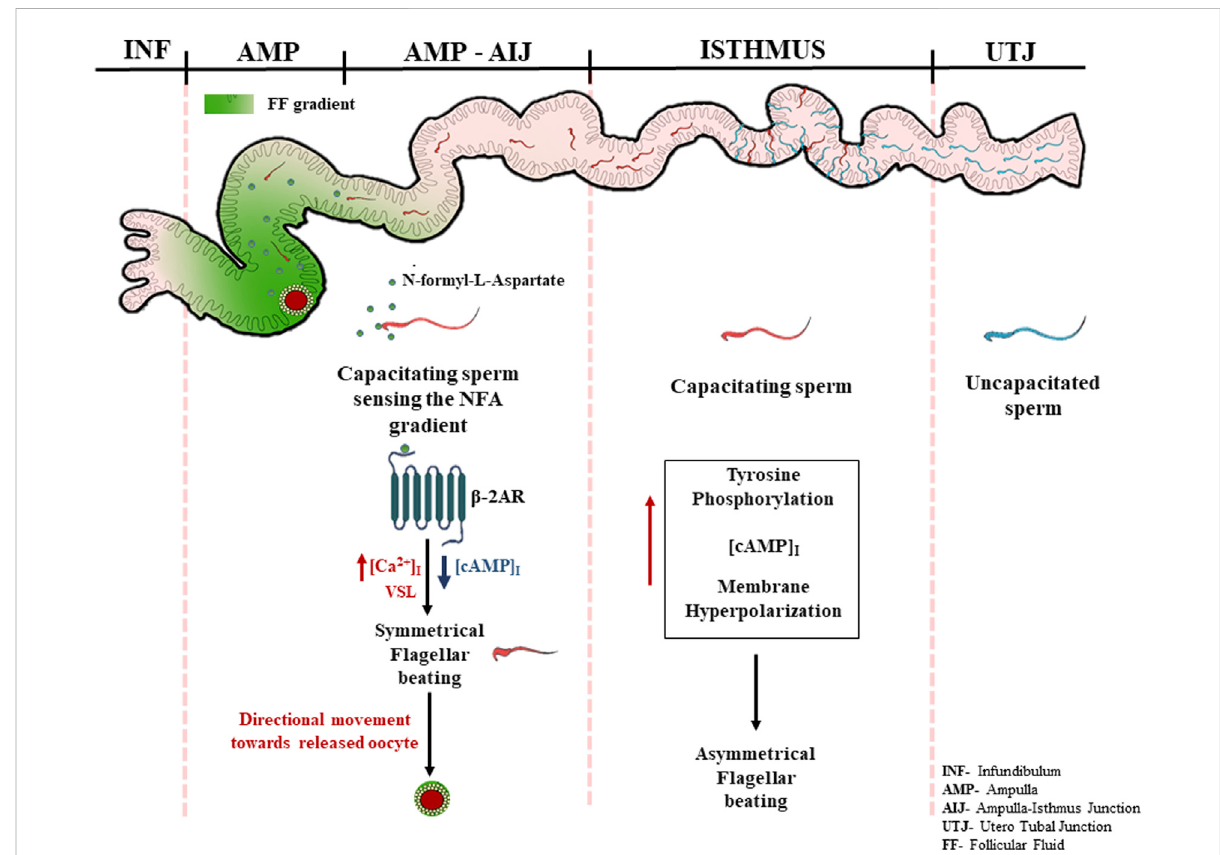
FIGURE 7 Schematic representation for the mechanism of chemotaxis mediated by